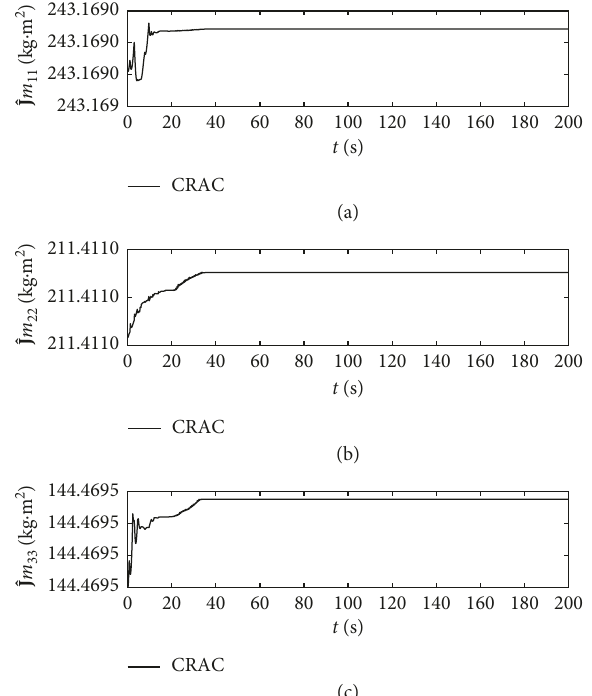
Figure 11: Time response of estimated parameters of inertia in Case 2.